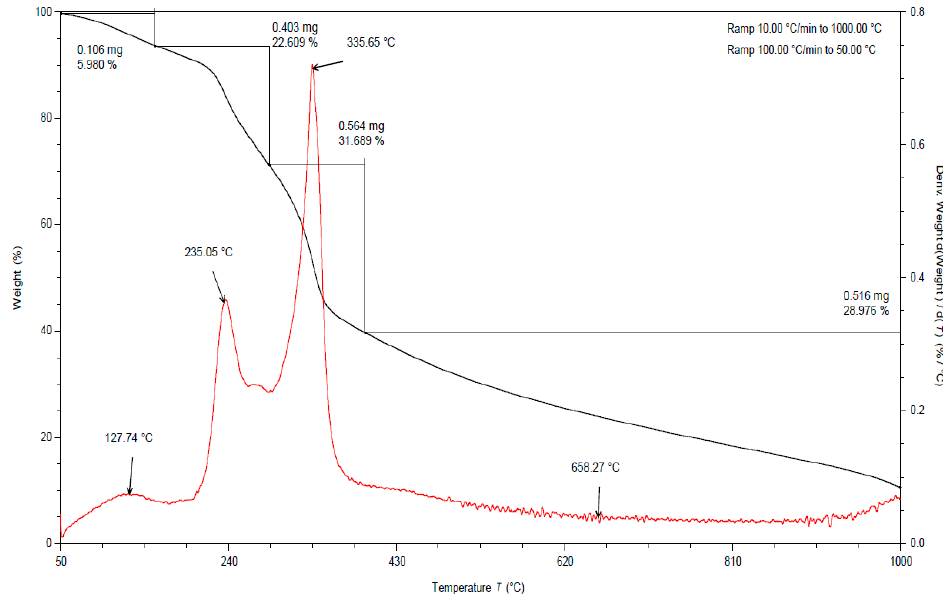
Figure 2. TGA curve for apple pomace dried to dry weight. Analysis in a nitrogen atmosphere (black line is a plot of mass loss versus temperature, red line is the first derivative).